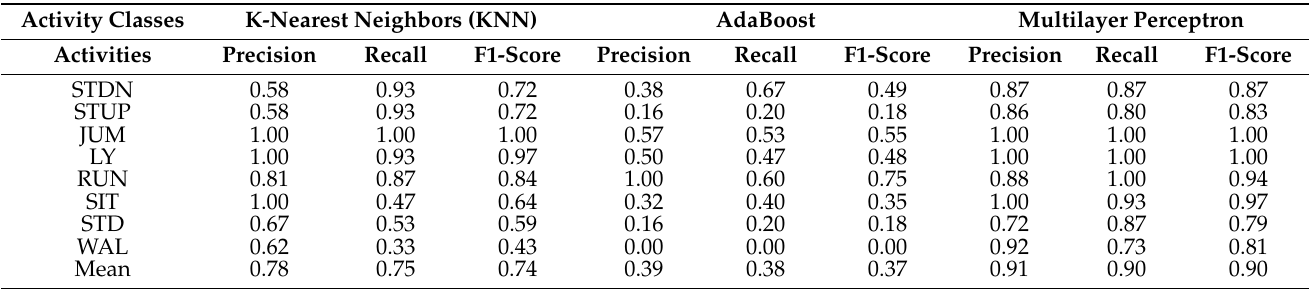
Table 4. Performance comparison of multilayer perceptron classifier with KNN and AdaBoost classifiers on Real-World HAR in terms of precision, recall, and